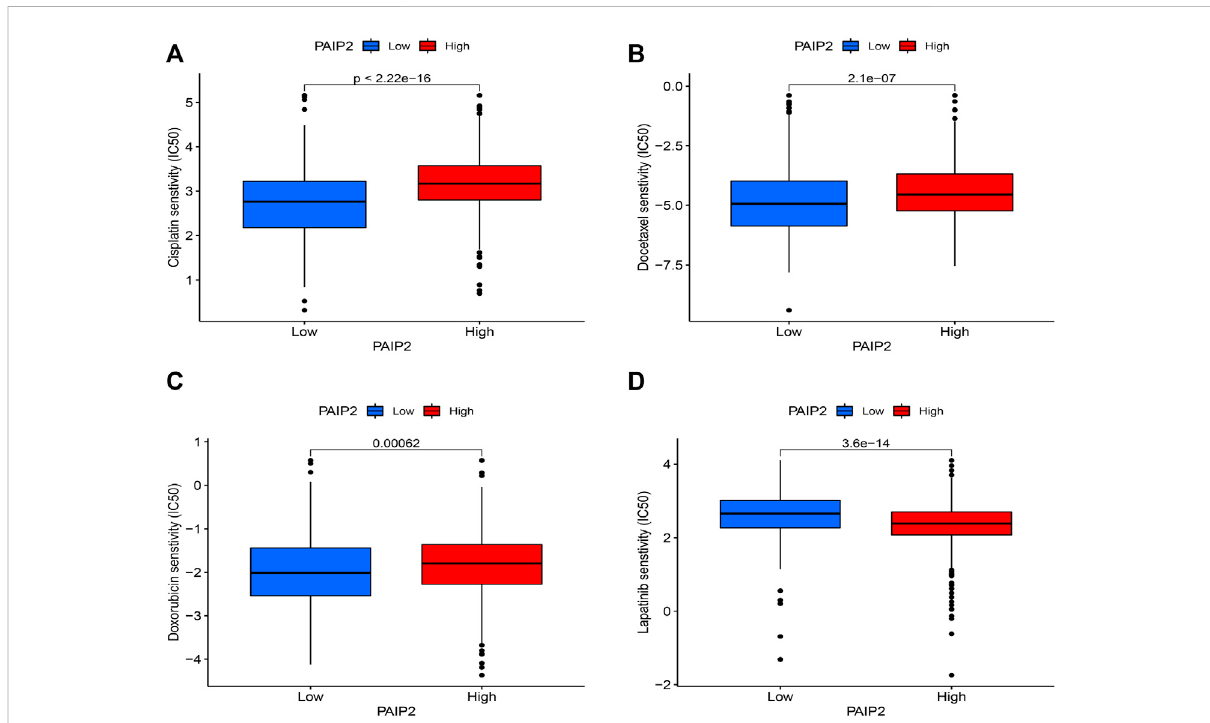
Correlation between PAIP2 and drug sensitivity. (A) : The expression of PAIP2 was positively correlated with the IC50 of Cisplatin and negatively correlated with the sensitivity of Cisplatin. (B) : PAIP2 expression was positively correlated with the IC50 of Docetaxel and negatively correlated with the sensitivity of Docetaxel. (C) : PAIP2 expression was positively correlated with Doxorubicin IC50 and negatively correlated with Doxorubicin sensitivity. (D) : PAIP2 expression was negatively correlated with IC50 of Lapatinib and positively correlated with sensitivity of